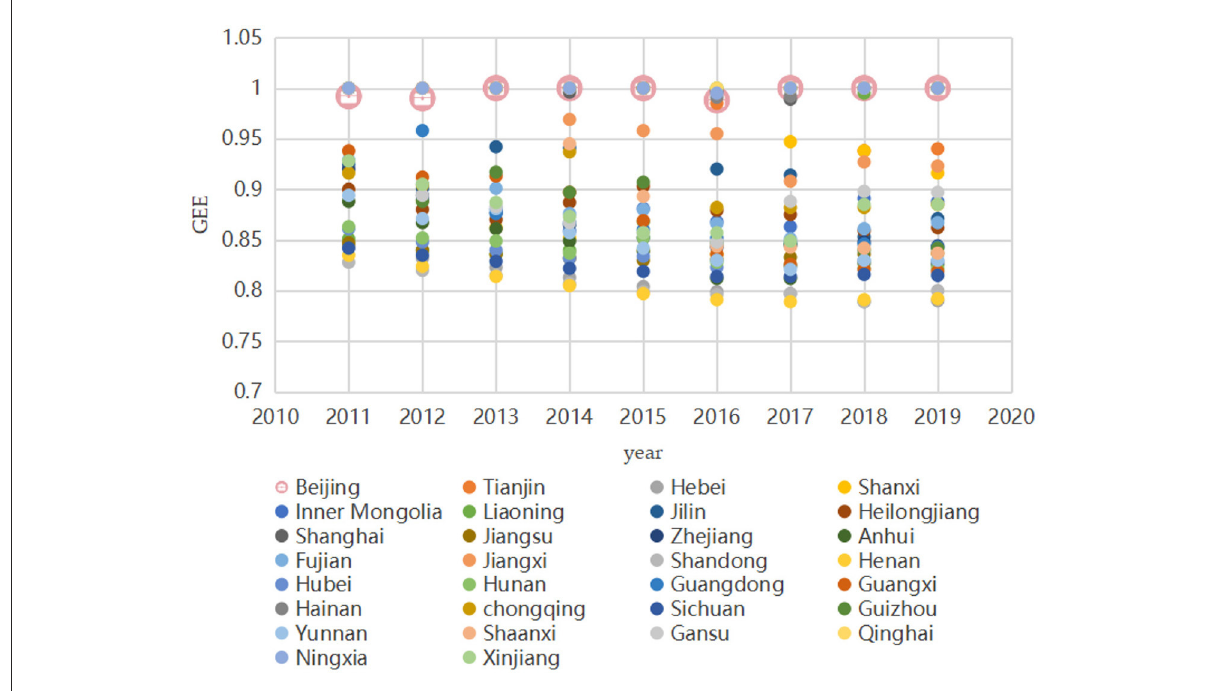
FIGURE4 Phase I green economy efficiency.